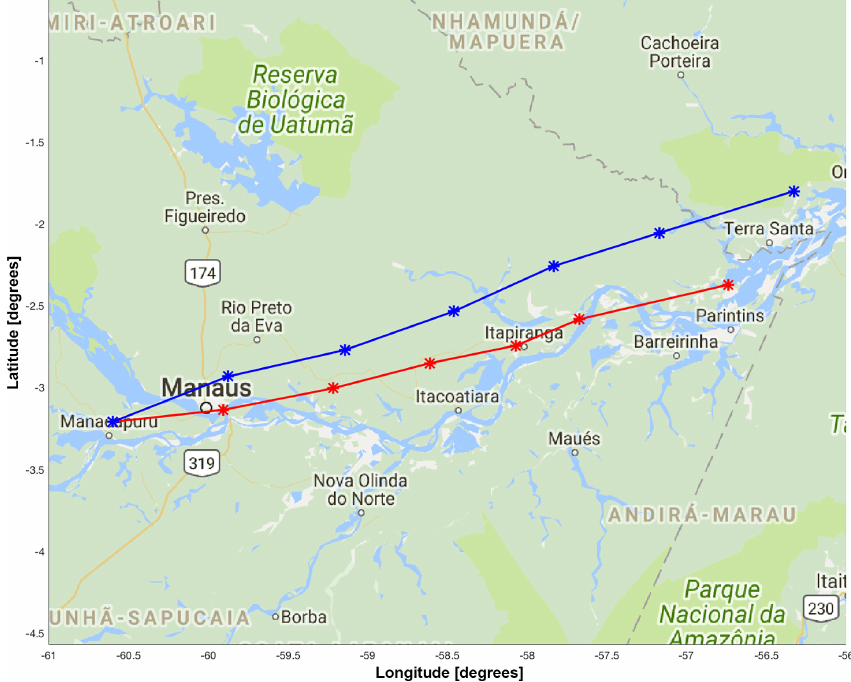
Figure 10. The median back trajectories for NPF (blue) and nonevent (red) days are shown. The trajectories were calculated as ensembles, 24h backwards, arriving at 09:00LT at 500ma.s.l. at the open pasture measurement